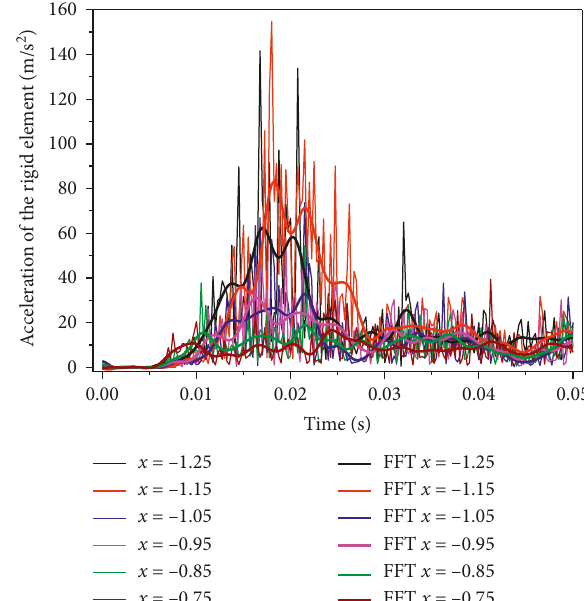
Figure 25: Acceleration of the tail beam.